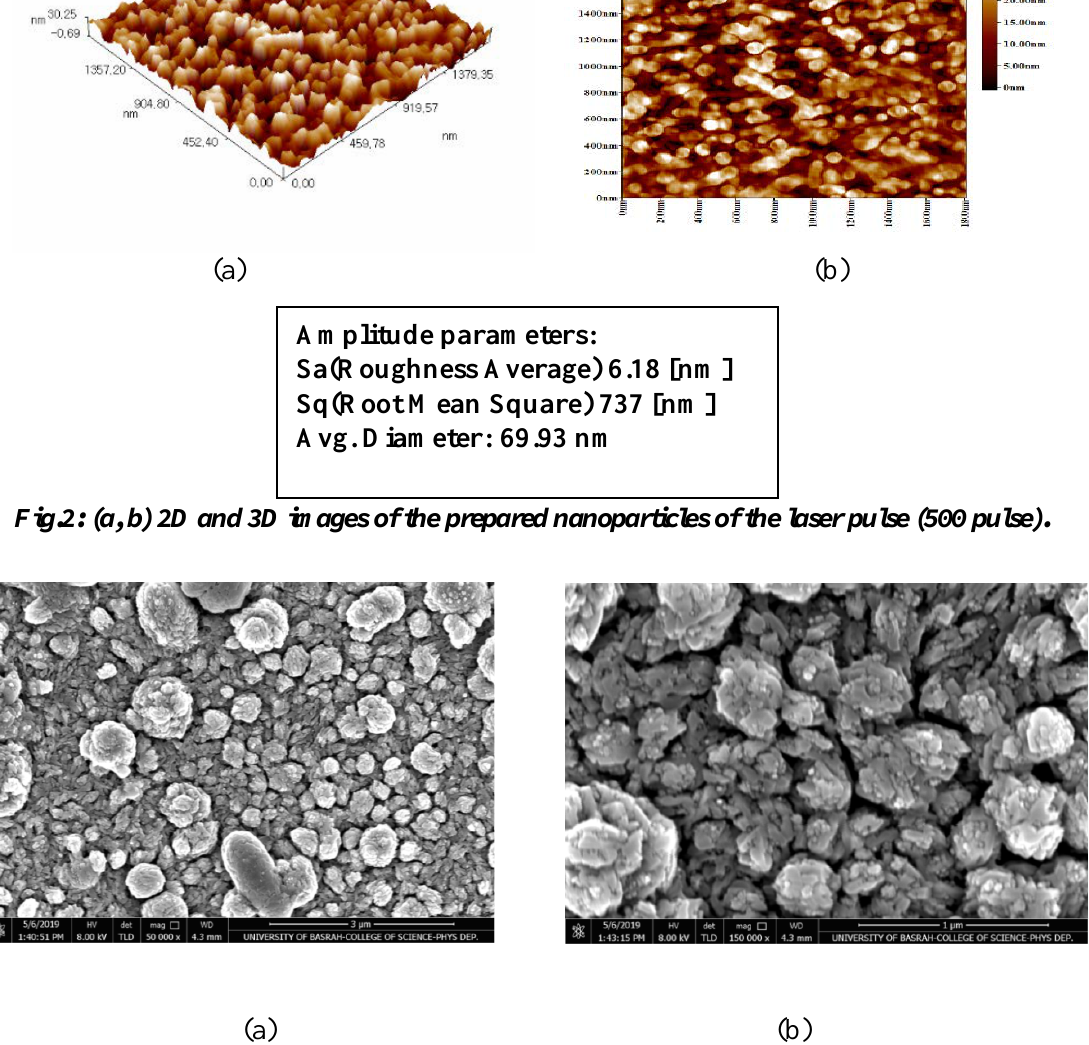
Fig.3: (a, b) Topographic composition and average size of the prepared laser pulse nanoparticles (500 pulse).